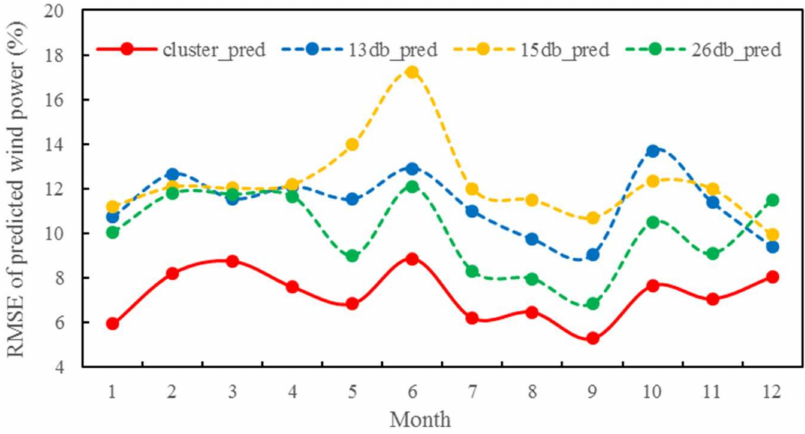
Figure 11. The monthly RMSE of the power predicted by different